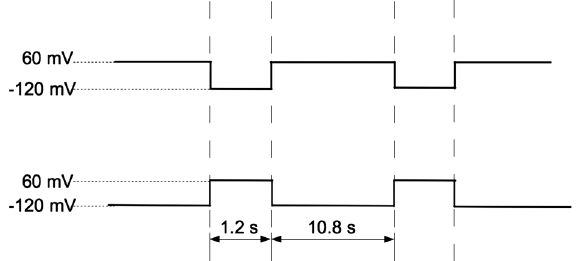
FIG. 17. The voltage protocols to determine the proportion of channels in the two orientations. The holding voltage of 60 mV in the top pulse inactivates all channels in the correct orientation. Thus, a step of (cid:2) 120 mV opens all the oppositely oriented channels while the channels oriented in the other direction are inactivated. The bottom pulse does the reverse and opens only the channels in the correct